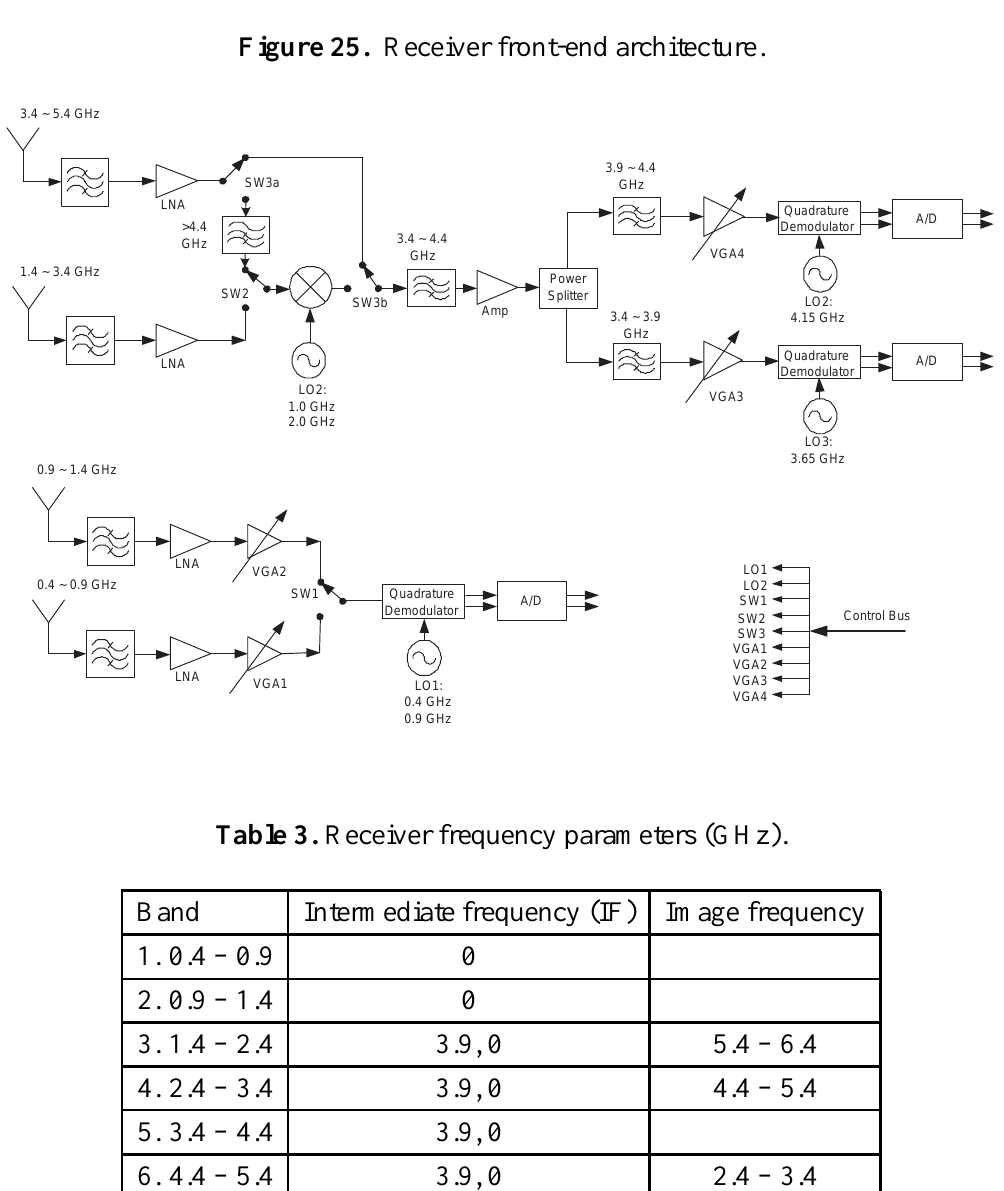
Figure 25. Receiver front-end architecture.